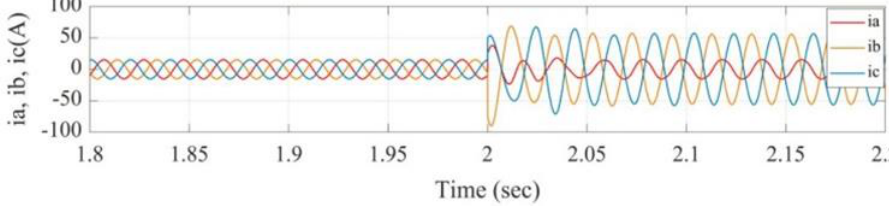
Figure 9. Phase a to ground fault current signal.